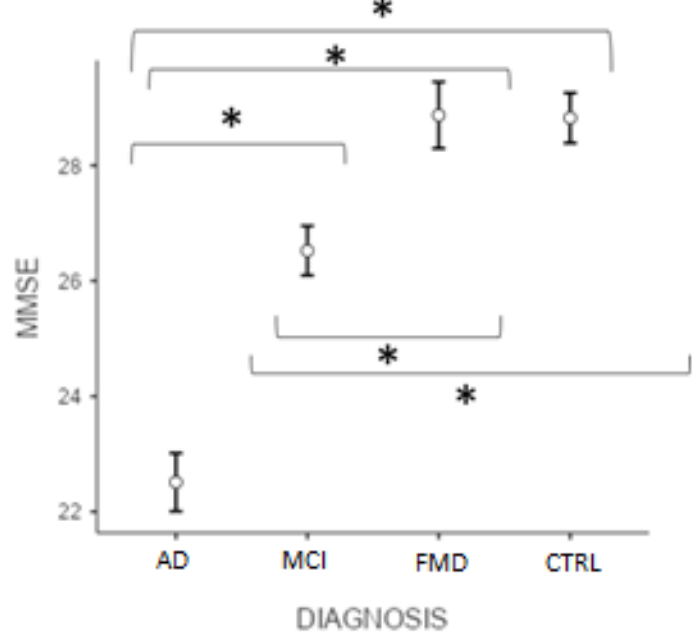
Figure 1. Differences between groups at MMSE total score. (* significant different, p < 0.001). AD = Alzheimer’s Disease; MCI = mild cognitive impairment; FMD = functional memory disorders; CTRL = controls.